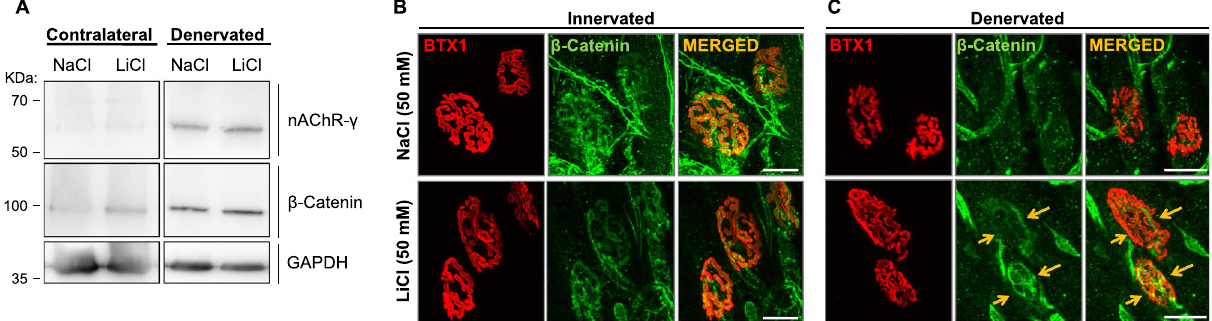
Figure 7. Lithium restricts the localization of β-catenin and nAChR γ-subunit at the NMJ. ( A ) Total protein samples of LAL muscles from NaCl- and LiCl-treated mice were analysed by Western blot using specific antibodies to detect the nAChR γ-subunit (upper panel) or β-catenin (middle panel). The levels of GAPDH were used as loading control (bottom panel). ( B , C ) Whole-mounted LAL muscles were subjected to immunofluorescence analyses to detect β-catenin (pseudocoloured green) in uninjured ( B ) and denervated ( C ) NMJs treated with 50 mM NaCl or LiCl. Pre-existing nAChRs were labeled in vivo with 488Alexa-BTX (BTX1, pseudocoloured red). Arrows show β-catenin staining in specific foci within the endplate of lithium-treated fibres. Bar = 20